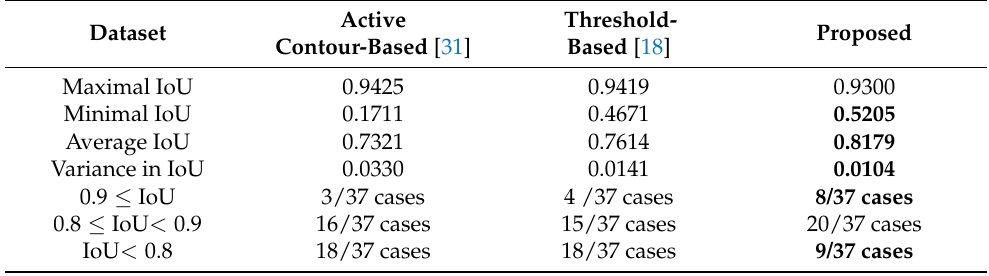
Table 8. Comparison of results in the TMUEH dataset with reproduced algorithms with IoU.